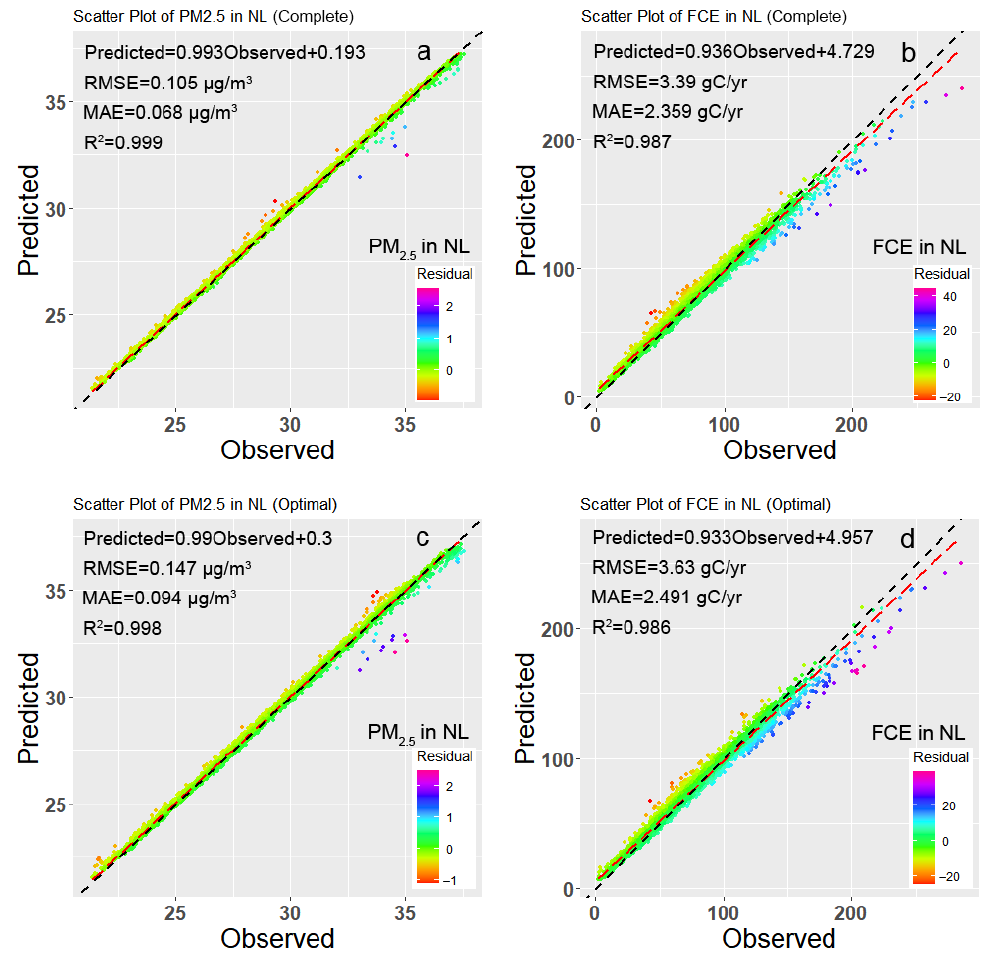
Figure 6. Scatterplots of the observed and predicted PM 2.5 and FCE from the RF regression ( a , b ) complete and ( c , d ) optimal variables during 2003 – 2019. plete and ( c , d ) optimal variables during